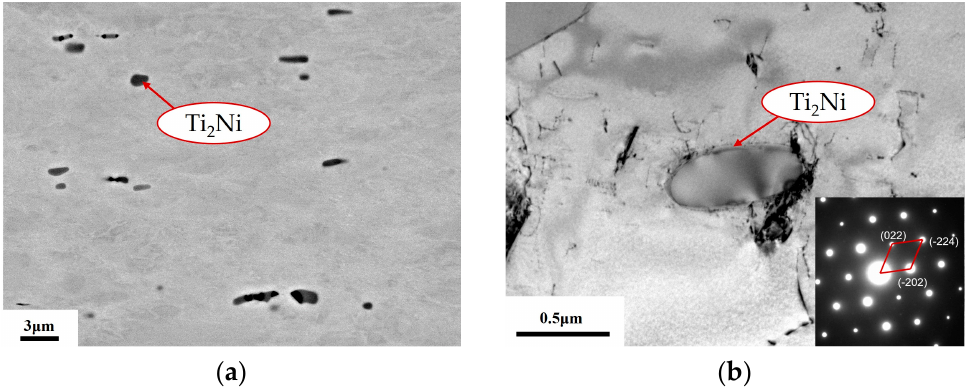
Figure 3. The SEM and TEM images of Ti 2 Ni-phase particles. ( a ) SEM-BED and the EDS analysis show the composition of the second phase; ( b ) TEM-bright fi eld image (inset is the corresponding SAED).